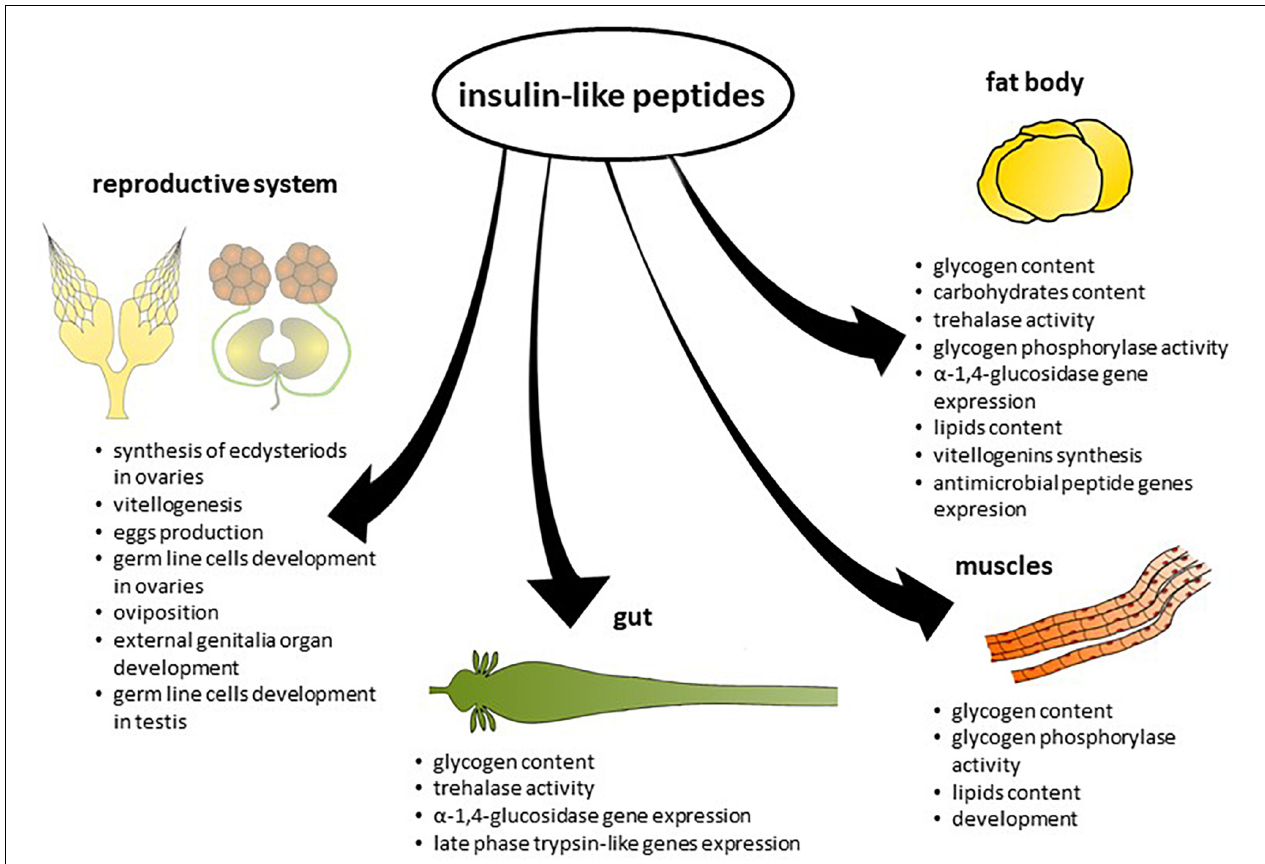
FIGURE 2 | Effects of insulin-like peptides on different